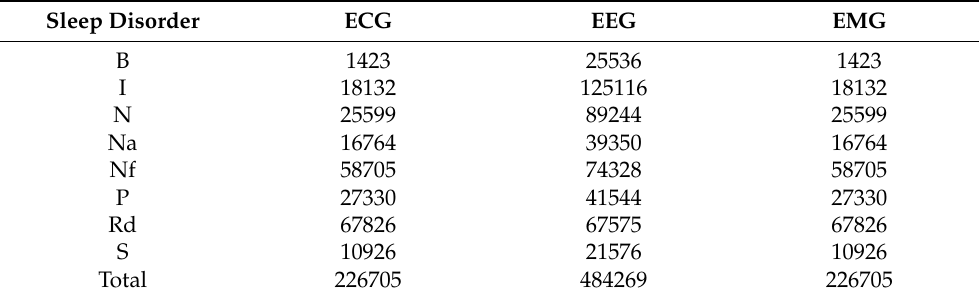
Table 2. Number of spectrogram images calculated for eight sleep disorders (N: normal sleep, B: Brux- ism, I: insomnia, Na: narcolepsy, Nf: nocturnal frontal lobe epilepsy, P: periodic leg movements, Rd: REM behavior disorder, S: sleep-disordered breathing) and three modalities (ECG, EEG, and